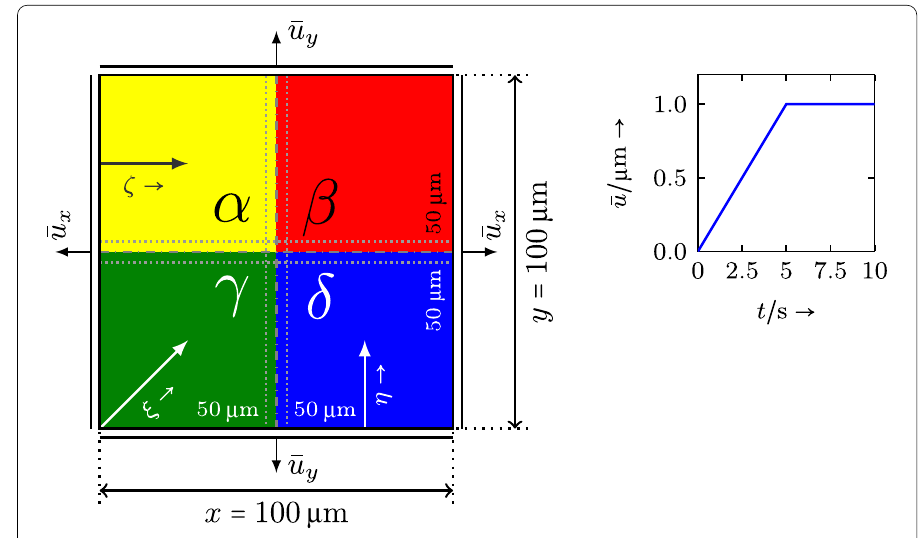
Fig. 16 Setup: Plate consisting of four regions with the same sizes and meeting at a multi-point in the centre. The x- and y-boundaries are exposed to a variable load (see graph on the right). The coordinate ζ starts at (0 . 0 µ m , 74 . 5 µ m) and η at (74 . 5 µ m , 0 . 0 µ